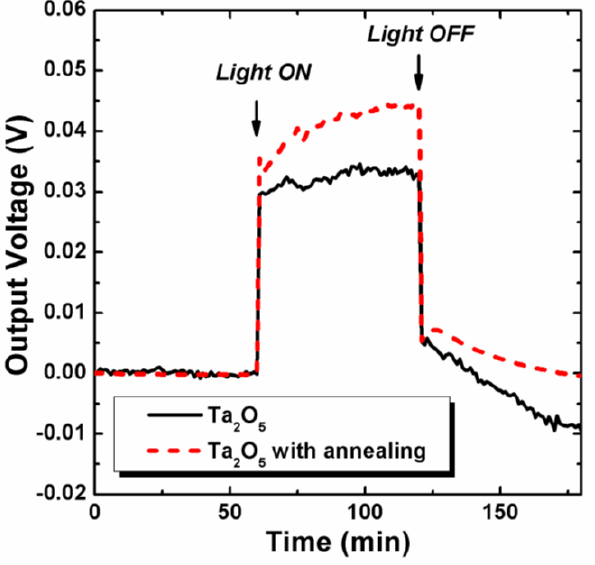
O ISFETs without and with post annealing. 2 5